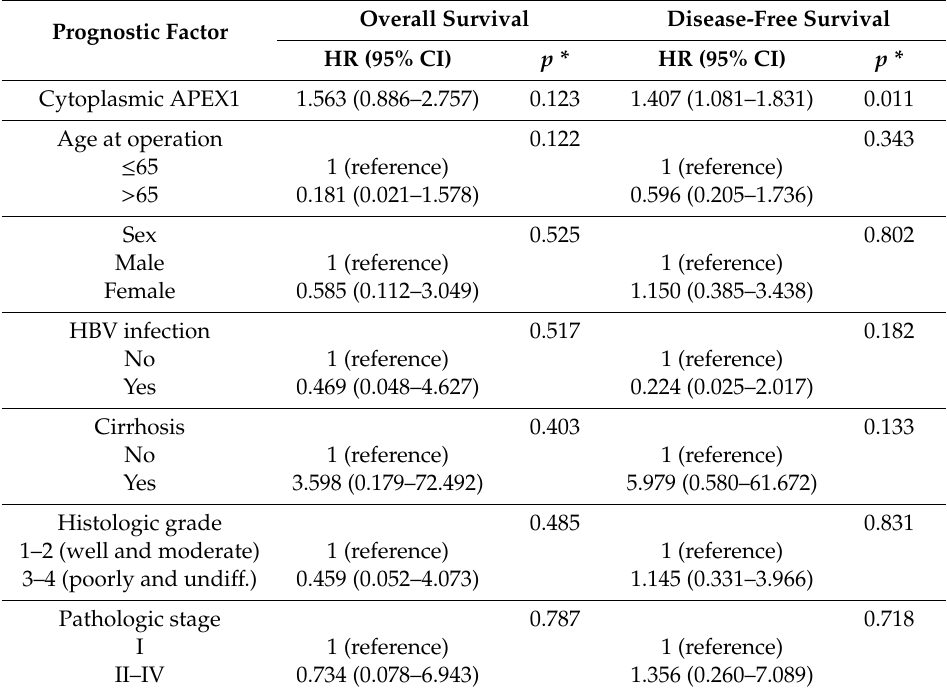
Table 6. Multivariate analysis of overall survival and disease-free survival in 32 patients with primary intrahepatic